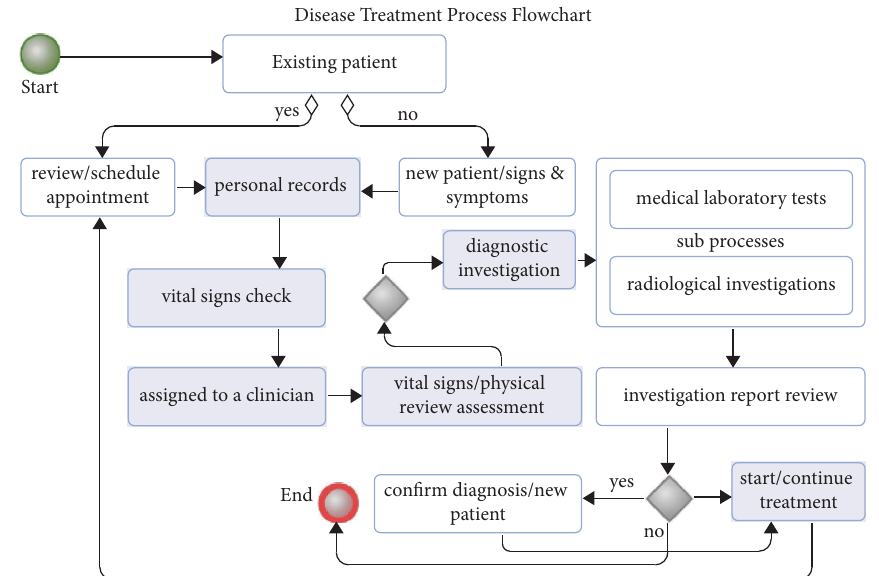
Figure 6: Flowchart diagram of the disease treatment process.